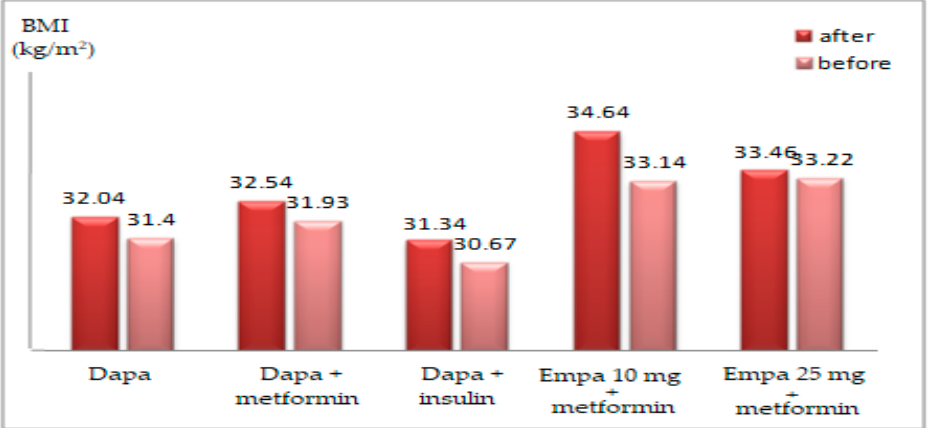
Figure 4. The mean BMI evolution according to the treatment